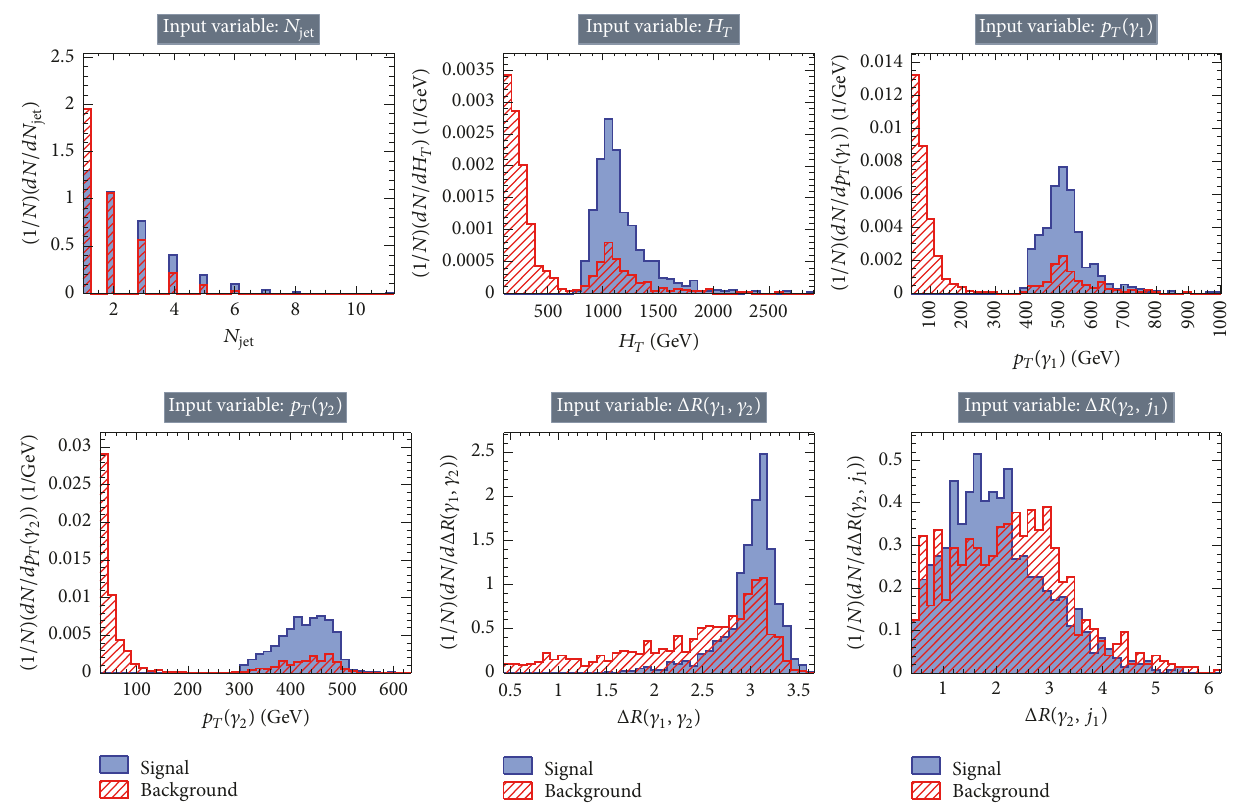
Figure 8: Normalized distributions of a few sample input variables for the signal ( 𝑔𝑔 fusion with 𝑀 Φ = 1 TeV) and background at the LHC ( √𝑠 = 13 TeV). These distributions are obtained by applying the selection cuts defined in Section